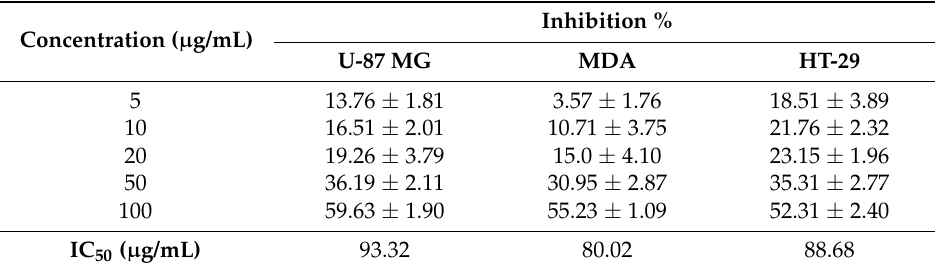
Table 5. Cytotoxic activity of extract of Streptomyces sp.S2A against HT-29, MDA and U-87 MG.